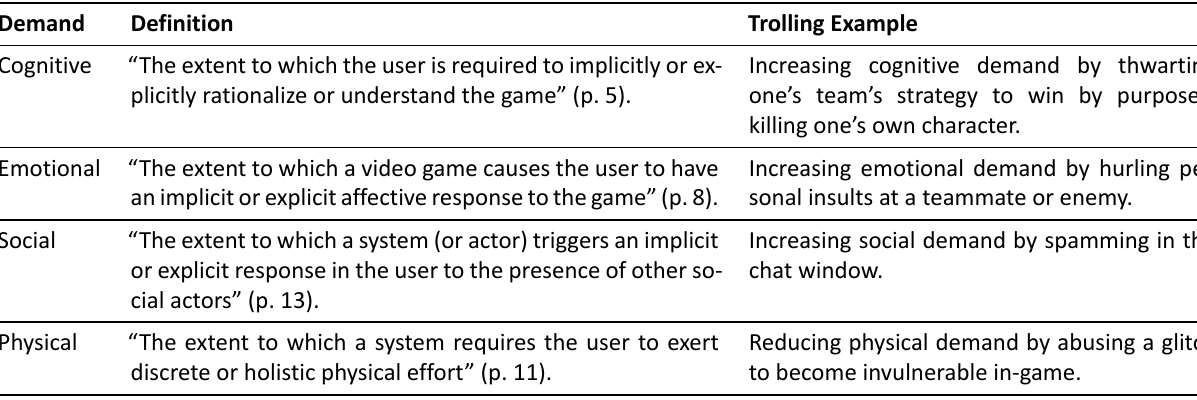
Table 1. Definitions of demands as presented by Bowman